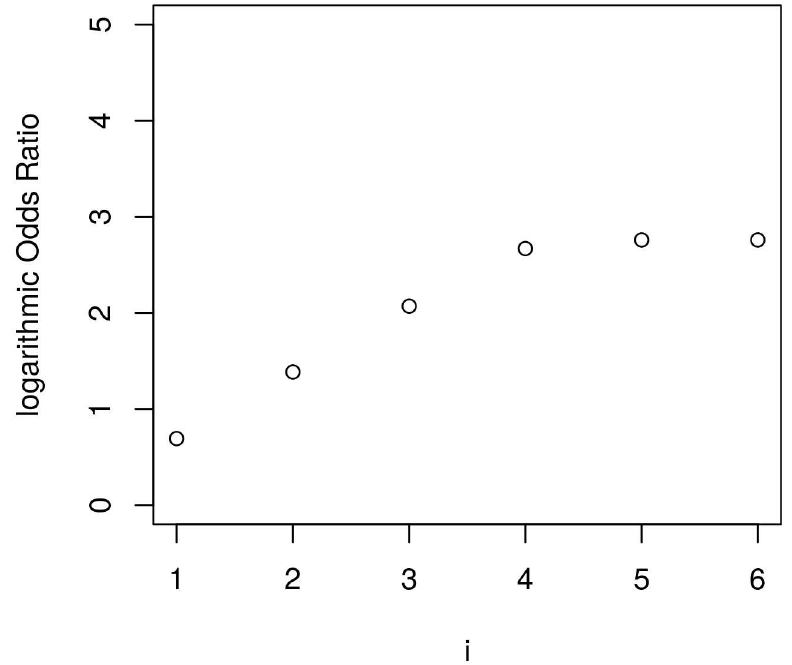
Fig 6. OR Diagram for 2 i (cid:1) 6 i processors. Using F ( t ) =